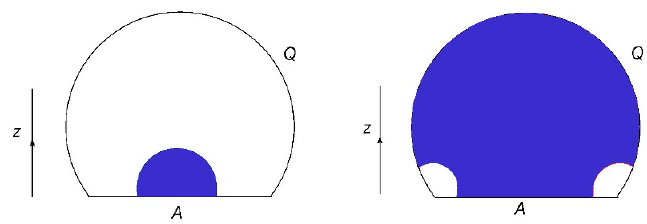
Figure 5 . Entanglement wedge for small A and large A